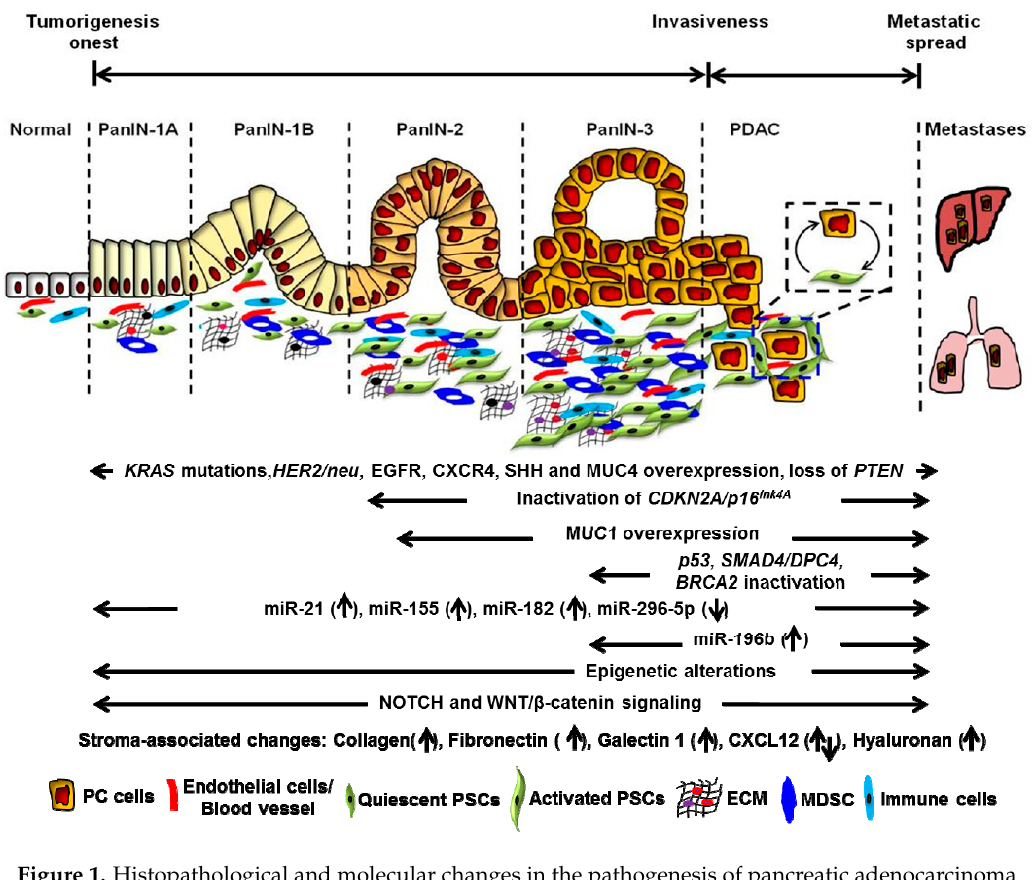
Figure 1. Histopathological and molecular changes in the pathogenesis of pancreatic adenocarcinoma (PDAC). The illustration describes the multistep PDAC development, starting from normal epithelium to low-grade pancreatic intraepithelial neoplasia (PanINs) and on to high-grade PanIN and invasive carcinoma. During this progression, several alterations in key genes ( KRAS , CDKN2 , TP53 , SMAD4/DPC4 and BRCA2 ) are accumulated. Apart from genetic alterations, deregulated signaling pathways, stromal associated factors and microRNAs serve as fuel for the development of aggressive pancreatic cancer. KRAS: Kirsten rat sarcoma oncogene homolog; Her-2/neu: Human epidermal growth factor receptor 2; EGFR: Epidermal growth factor receptor; CXCR4: C-X-C chemokine receptor type 4; SHH: Sonic hedgehog; MUC4: Mucin 4; PTEN: Phosphatase and tensin homolog; CDKN2A/p16 Ink4A : Cyclin dependent kinase inhibitor 2A; SMAD4/DPC4: Mothers against decapentaplegic homolog 4/ Deleted in pancreatic cancer-4; BRCA2: Breast cancer type 2 susceptibility protein; CXCL12: C-X-C motif chemokine 12.